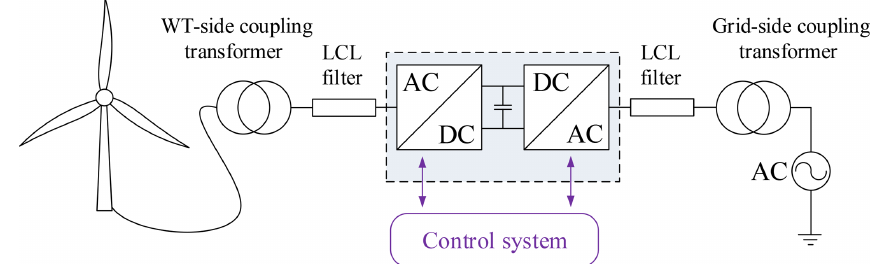
Figure 2. Single-line diagram of a VSC-based test equipment.